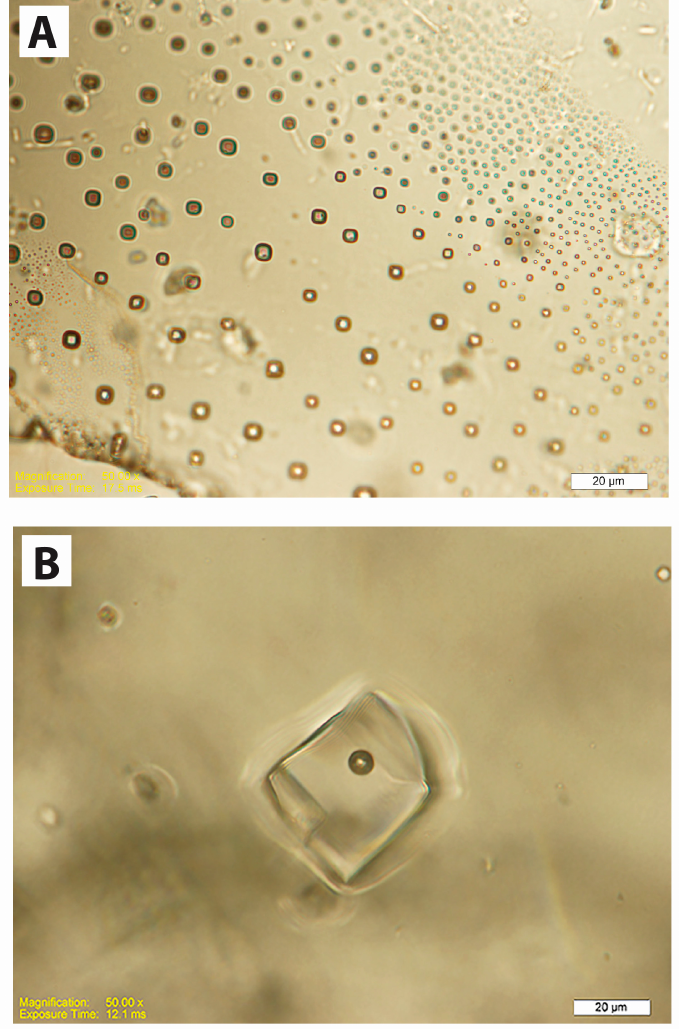
Figure 1. Photomicrographs of sylvite crystals from Boulby, showing aqueous fluid inclusions. ( A ) planar arrays of monophase inclusions parallel to crystal growth zones; ( B ) isolated inclusion with a vapour bubble. Scale bars are each 20 microns.